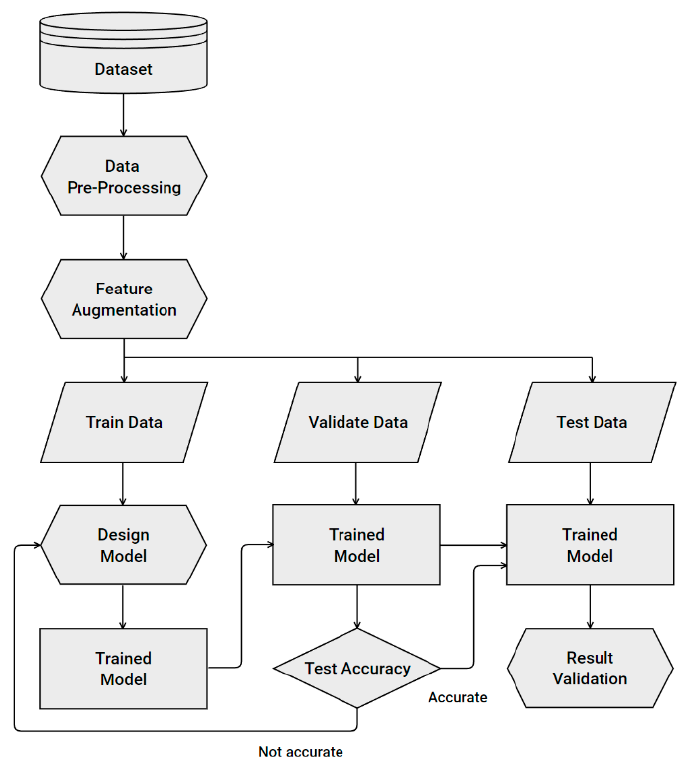
Figure 1. Algorithm construction diagram.